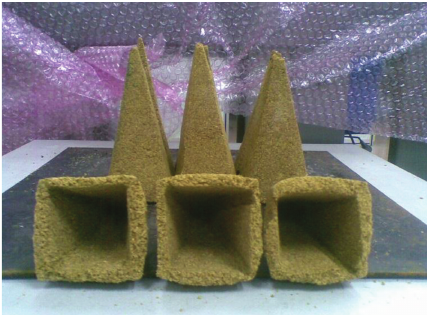
Figure 8: Fabricated hollow pyramidal parts of the absorbers, with- out a square base part, height (11cm), and average wall thickness of 10